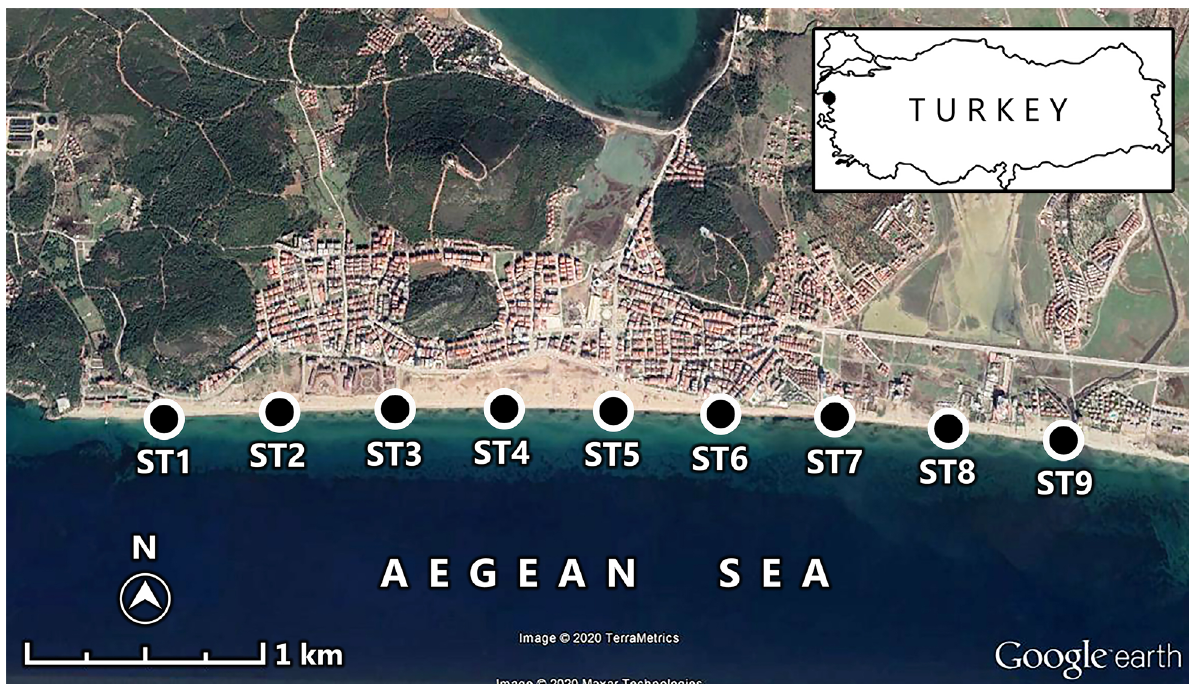
Figure 1. The study area and the sampling